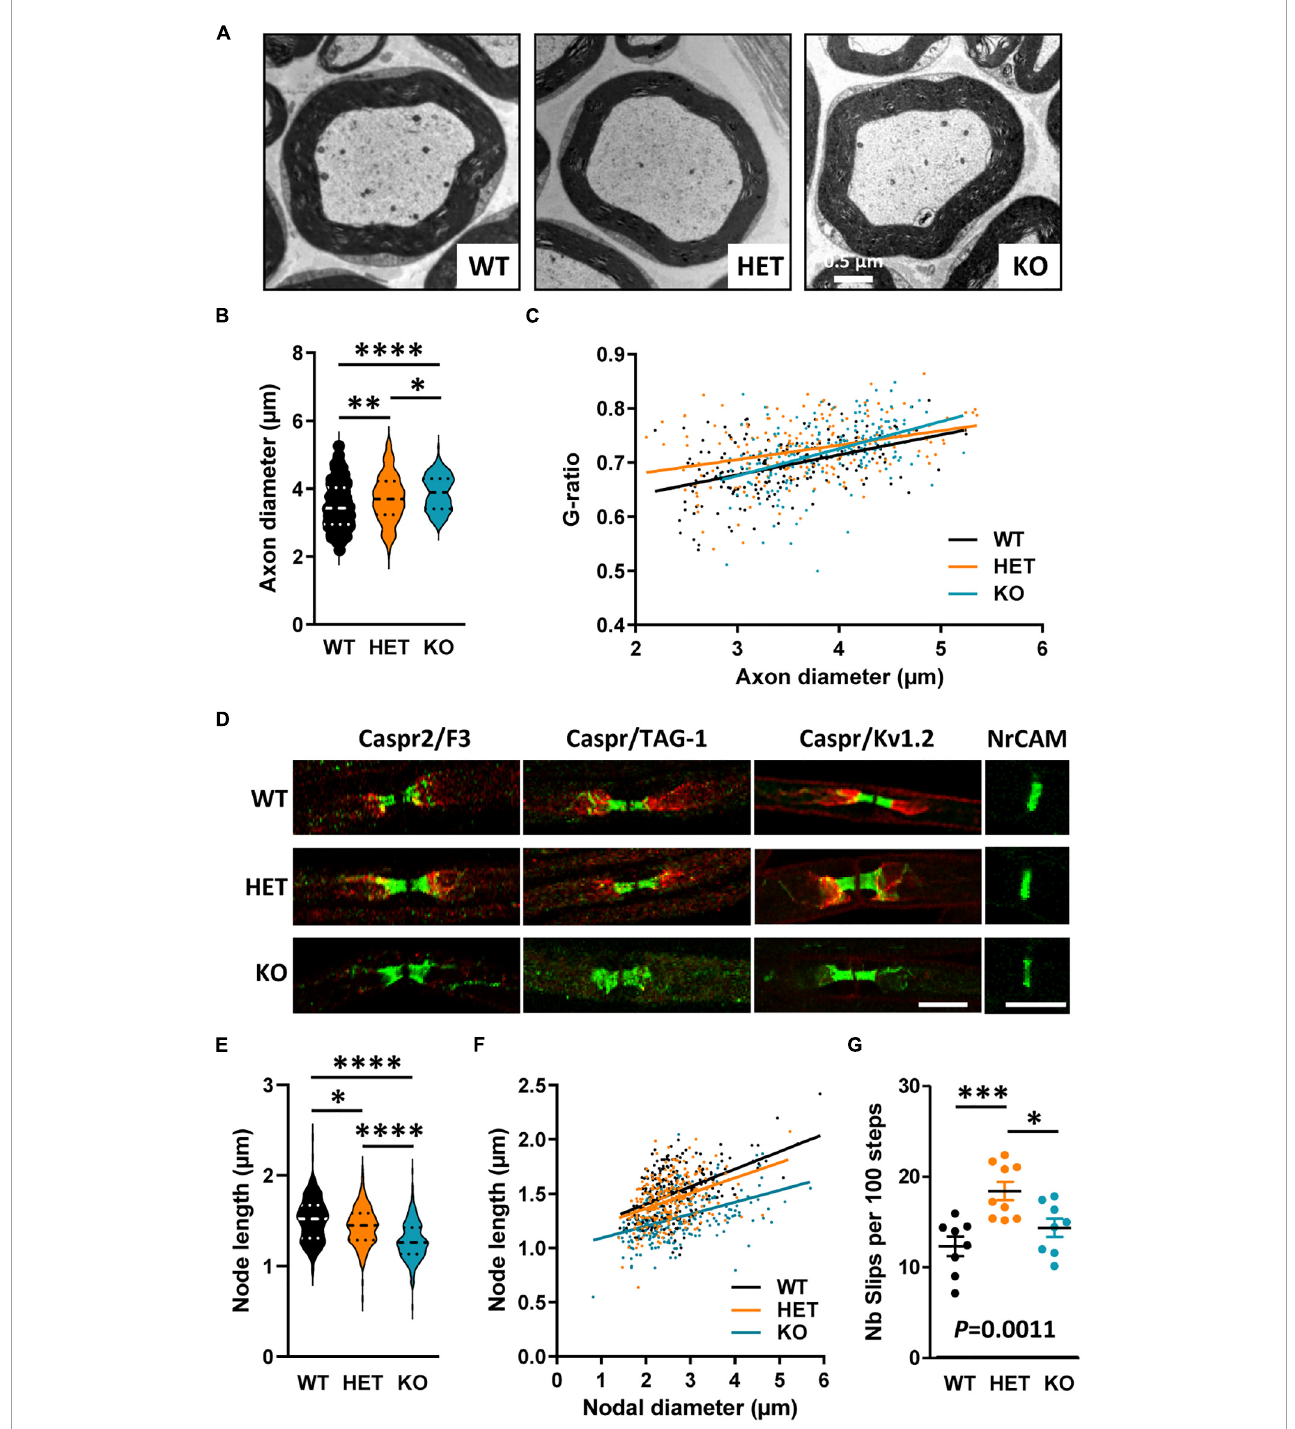
FIGURE9 Myelinated fiber abnormalities in sciatic nerves of adult mice. Electron micrographs of transversal sections of the sciatic nerve of wild-type (WT), HET, and KO adult mice, showing a single myelinated fiber for each genotype (A) . Axonal diameters of myelinated fibers (B) . Scatter plot graph displaying G-ratios of individual myelinated axons as a function of the respective axon diameters, and the linear regression of the G-ratio measurements for each genotype (C) . Representative confocal images of immunostainings of sciatic nerves fibers from WT, HET, and KO adult mice, for nodal (NrCAM), paranodal (Caspr, F3), and juxtaparanodal (Caspr2, TAG-1, Kv1.2) proteins (D) . Length of the nodes measured on NrCAM immunostainings (E) . Scatter plot graph displaying length of individual node as a function of the respective nodal diameters, and the linear regression of the node length measurements for each genotype (F) . Number of slips per 100 steps made by WT, HET, and KO adult males during the grid-walking test (G) . (B,C) 141 myelinated fibers/genotype, 4 mice/genotype, 47 myelinated fibers/mouse, (E,F) 243 nodes/genotype, 3 mice/genotype, 81 nodes/mouse, (G) 8–9 mice/genotype. Statistical tests: (B,E) Kruskal–Wallis test to compare the three genotypes; (C) Linear regression (WT R 2 = 0.2093, HET R 2 = 0.1143, KO R 2 = 0.2022) for pairwise comparisons, HET vs. WT elevation P < 0.0001, HET vs. KO slope P = 0.019; (F) Linear regression (WT R 2 = 0.2295, HET R 2 = 0.1368, KO R 2 = 0.1935) for pairwise comparisons, HET vs. WT elevation P = 0.0052, KO vs. WT slope P = 0.0315, HET vs. KO elevation P < 0.0001; (G) one-way ANOVA test to compare the three genotypes; ∗ P < 0.05, ∗∗ P < 0.01, ∗∗∗ P < 0.001, ∗∗∗∗ P < 0.0001. Bar scales, 10 µ m (E)